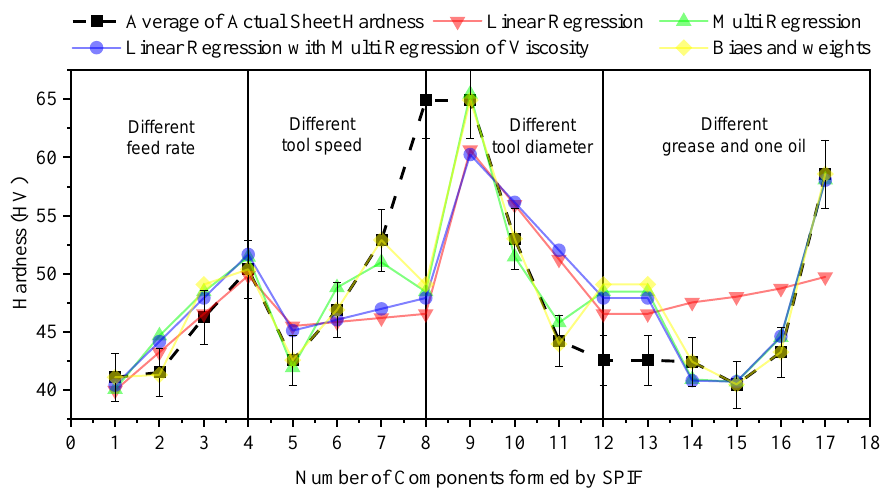
Figure 10. Calculated and real hardness of SPIF components.